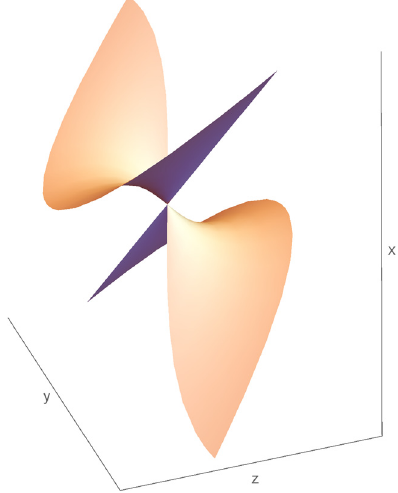
Figure 18: Enneper ’ s rotation surface of second kind in (cid:2) 3